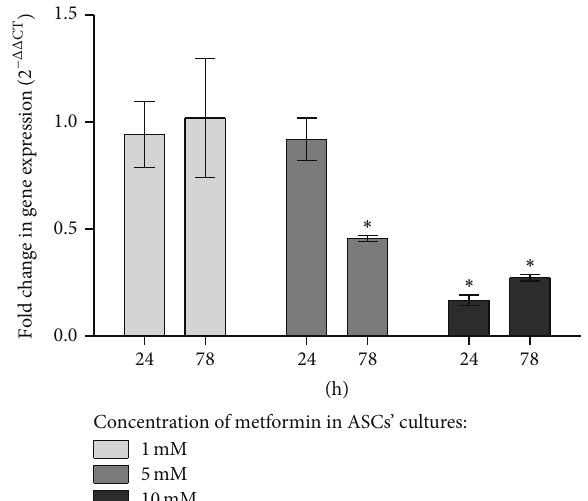
Figure 8: Expression of mRNA for OPN in experimental cul- tures. Quantification of relative values was performed using 2 −ΔΔ CT method, normalizing data to control culture and including expres- sion of reference gene. Data are presented as the mean fold change of relative expression and compared to control cultures (normalized to 100%); error bars represent standard deviation from themeancalculatedfornormalizedvaluesobtainedinthreeseparate reactions; asterisks represent statistically significant differences ( 𝑃 < 0.05 ).